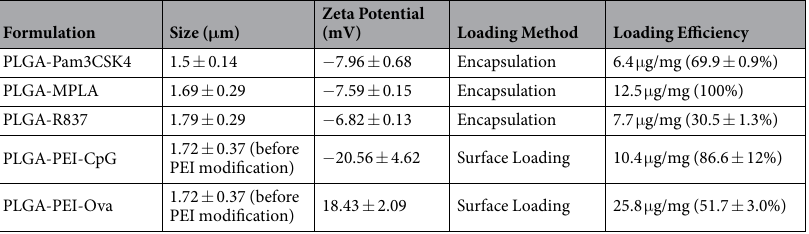
Table 1. Size, Zeta potential, and representative encapsulation/loading efficiency of PLGA-microparticles (PLP). The data shown are average of at least 2 (Pam3CSK4), 3 (Ovalbumin) or 5 (MPLA, R837, and CpG) batches.